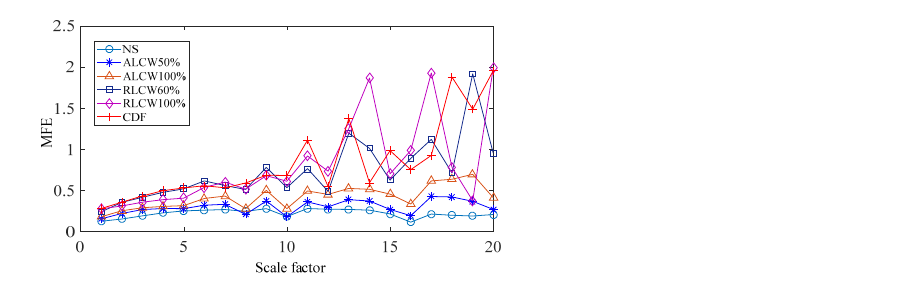
Figure 11. Change curves of the MFE values corresponding to different scale factors in different states.